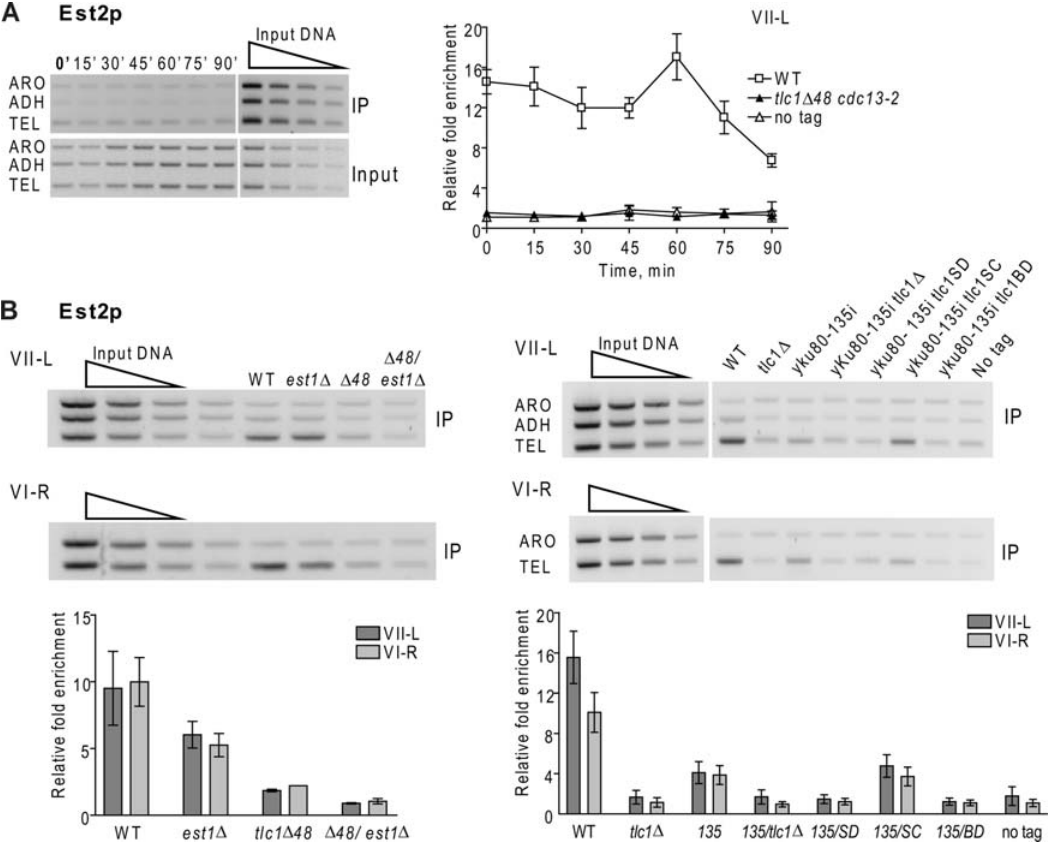
Figure 5. Est2p telomere binding is eliminated in mutants lacking both the G1 and the late S/G2 phase recruitment pathways. Methods are the same as in Figure 1 legend. A. Est2p binding to VII-L telomere in synchronous tlc1 D 48 cdc13-2 (black triangles) versus WT (white squares), or untagged (white triangles) cells. Est2p telomere binding in the double mutant was not different from the no-tag control (P=0.11 to 0.85) except at the 0 min time point (P=0.039). B. Est2p binding to VII-L (top) or VI-R (bottom) telomeres in asynchronous WT and mutant cells. Bar graphs show average Est2p association with telomere VII-L (dark grey) or VI-R (light grey). Abbreviations are D 48 , tlc1 D 48 ; 13-2 , cdc13-2 ; 135 , yku80-135i , SD, tlc1-SD ; SC, tlc1-SC ; BD, tlc1-BD . For double mutants, there is a slash between the two alleles as in D 48/est1 D which stands for tlc1 D 48 est1 D . Error bars indicating 6 one standard deviation from that average. Est2p binding was indistinguishable in tlc1 D versus the double mutants yku80-135i tlc1-SD or yku80-135i tlc1-BD cells (P values ranged from 0.28 to 0.85) while Est2p binding in the double mutant yku80-135i tlc1-SC was significantly greater than in tlc1 D (P=0.003, VII-L; 0.0001, VI-R).